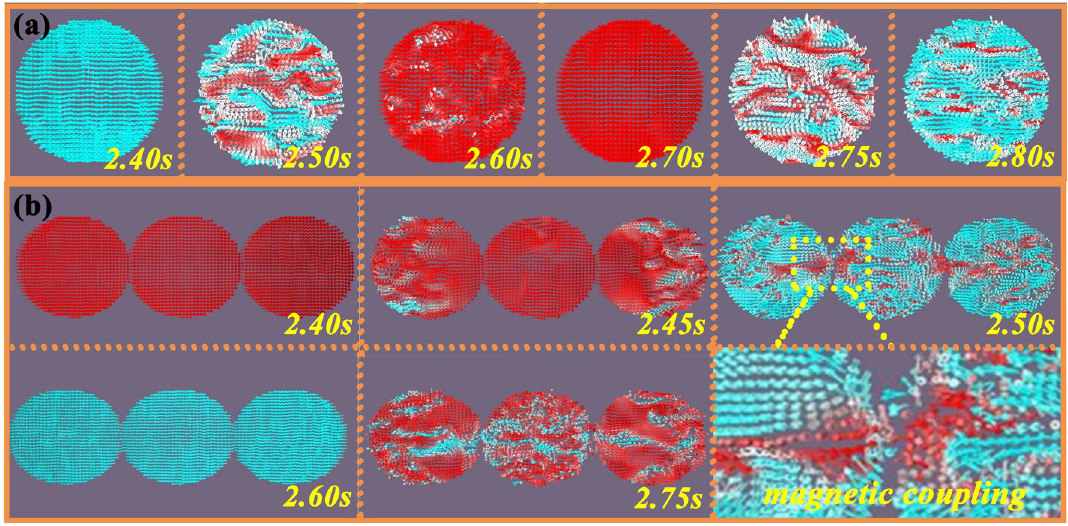
Fig. 6 Micromagnetic simulation result of a single Ni particle and b Ni